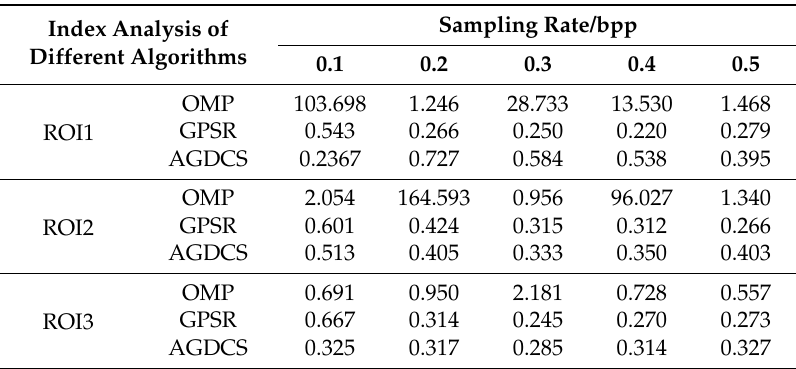
Table 4. RMSE comparison of spectral indices of CRI700.